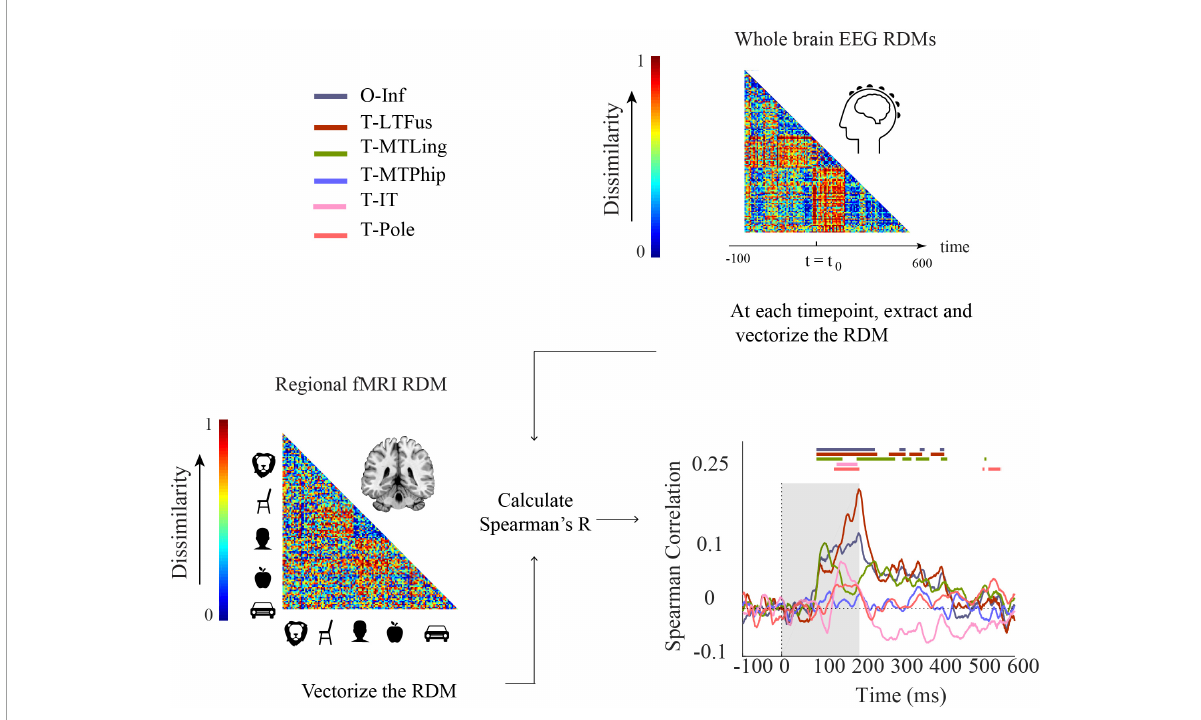
FIGURE6 Comparing fMRI and EEG by representational similarity. For each participant, EEG and fMRI RDMs were calculated using 1-Spearman’s correlation. We then compared the mean fMRI RDM to the mean EEG RDM. The horizontal lines above the curves indicate significant time points (permutation test over stimuli, 10,000 repetitions, FDR-corrected at p < 0.05). The ROIs include occipital-inferior (O-Inf), fusiform (T-LFus), lingual (T-MLing), parahippocampal (T-MTPhip), inferior-temporal (T-IT), and pole-temporal cortex